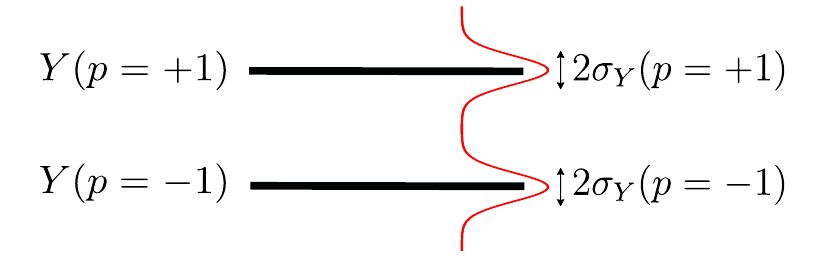
Figure 4: Diagram explaining definition of the signal and noise given by Eqs. (20),(21). Y is a measured quantity which depends on p , black lines indicate re- spective values of Y . The red line is a level broadening due to the noise with a standard deviation σ Y